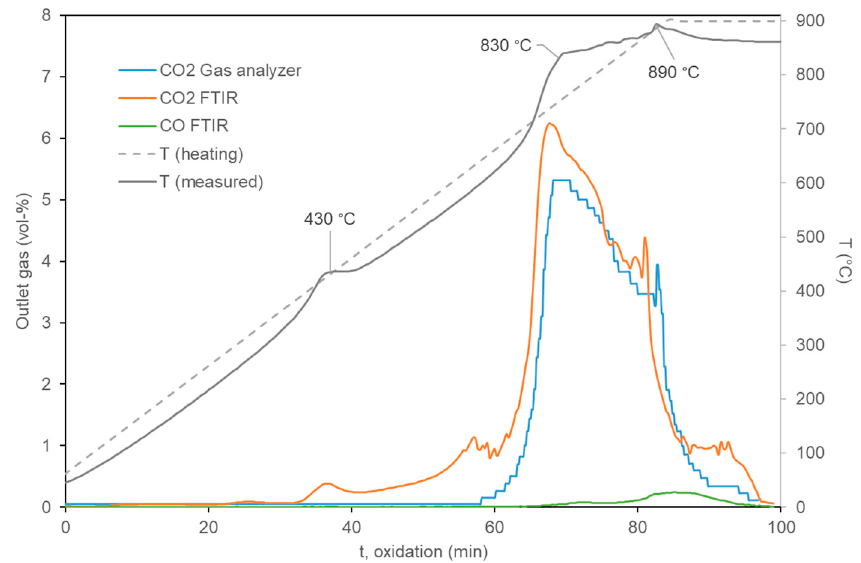
Figure 10. Oxidation by TPO method in run 14. Analysis of CO and CO 2 in outlet gas by FTIR and gas analyzer as a function of time from the beginning of the oxidation. Temperature measurement inside the reactor shows the corresponding peaks to major CO 2 peaks.